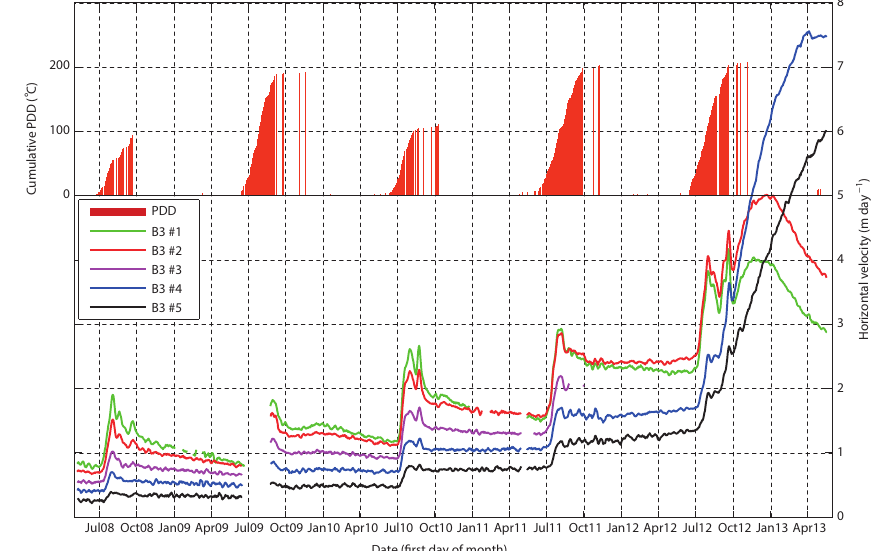
Figure 2. Flow velocities along the centreline of the fast-flow region of Basin-3, Austfonna, between May 2008 and May 2013. GPS stations are numbered from 1 at the lowest elevation to 5 at the highest (Fig. 1). Red bars (upper panel) indicate potential melt days and cumulative positive-degree days (PDD) for each summer, inferred from the temperature record of an automatic weather